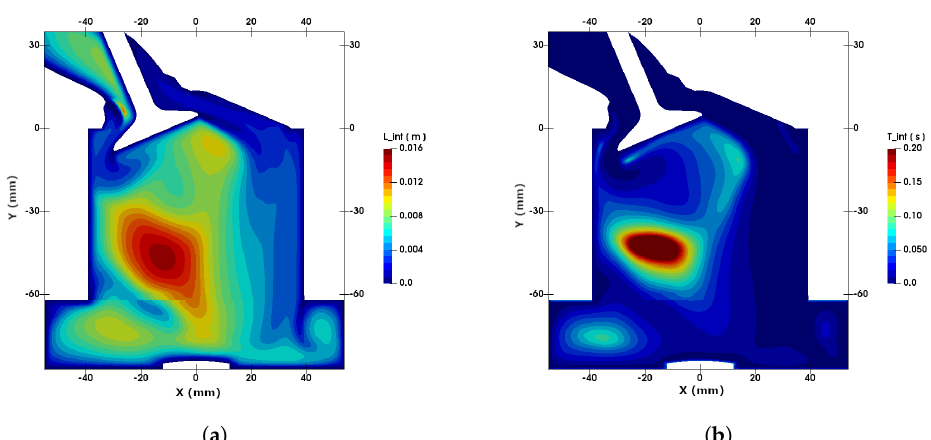
Figure 3. Integral length and time scales evaluated along one of the valve plane using k - ε model based simulation. ( a ) Integral length scale; ( b ) Integral time